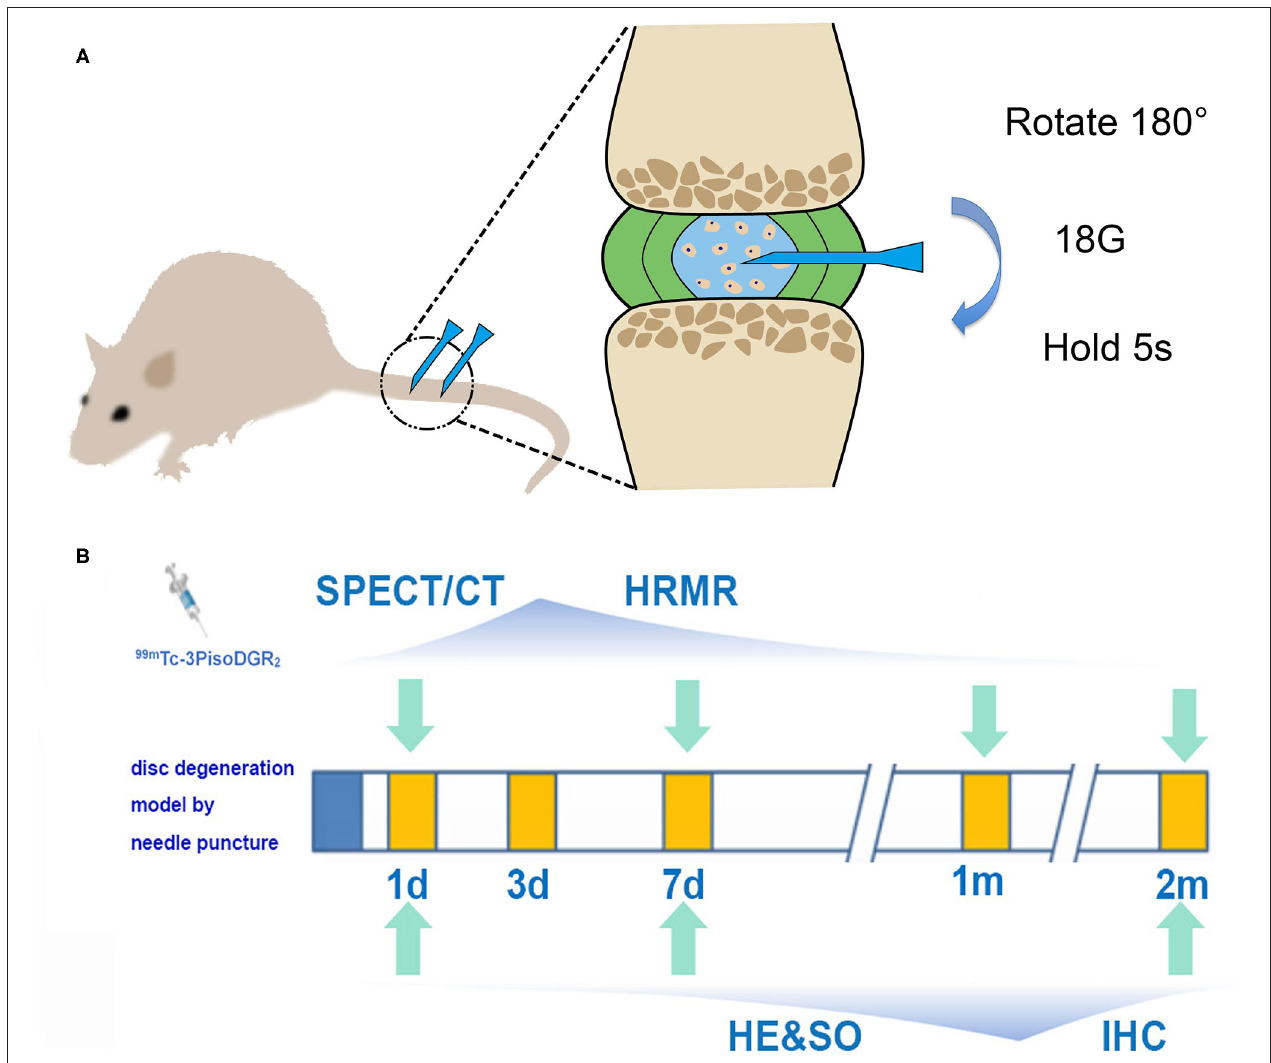
FIGURE 1 | (A) Schematic diagram of the model of disc herniation induced in rats by conducting an established needle puncture procedure. (B) Experimental flowchart. SPECT and MRI were performed 1 day, 1 week, 1 month, and 2 months postinjury. Histology was performed 1 day, 1 week, and 2 months postinjury (IHC, immunohistochemistry; HRMR, high-resolution MRI; HE, hematoxylin and eosin; SO, safranin-O